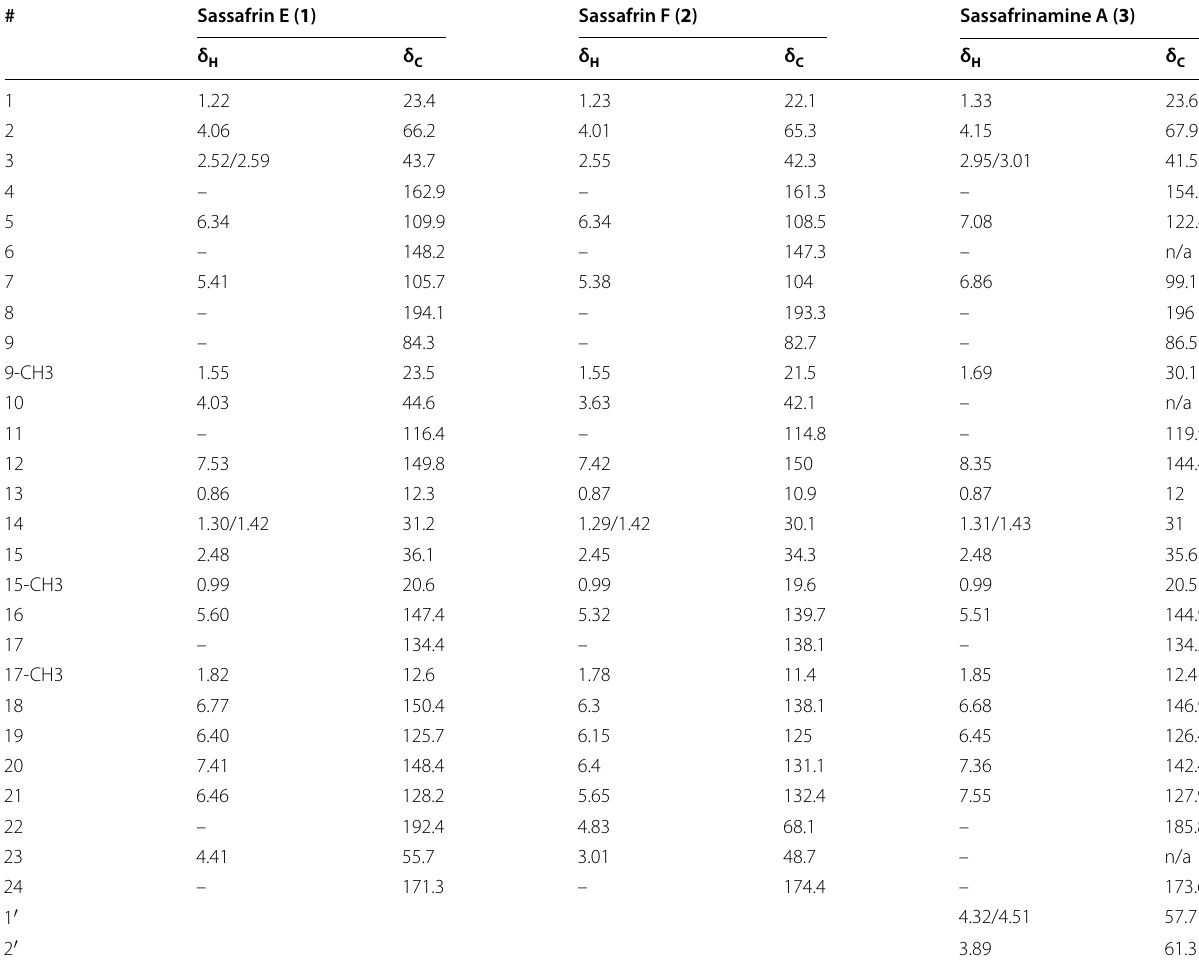
tional file 1: Fig. S4.